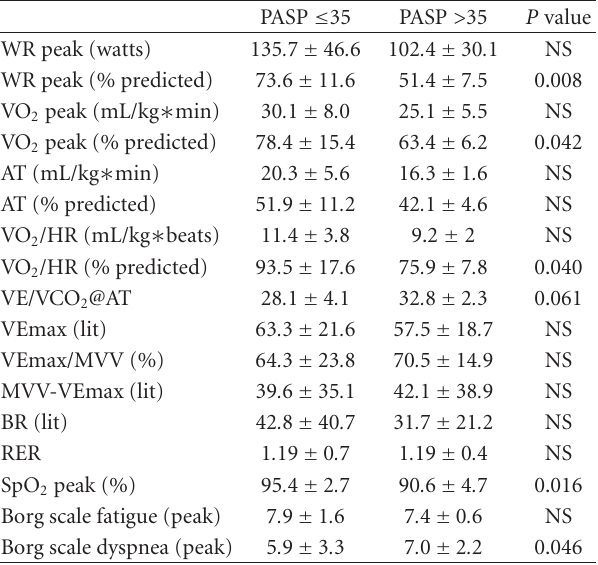
Table 3: Exercise parameters in cystic fibrosis patients with postexercise PASP ≤ 35 mmHg and postexercise PASP > 35mmHg.